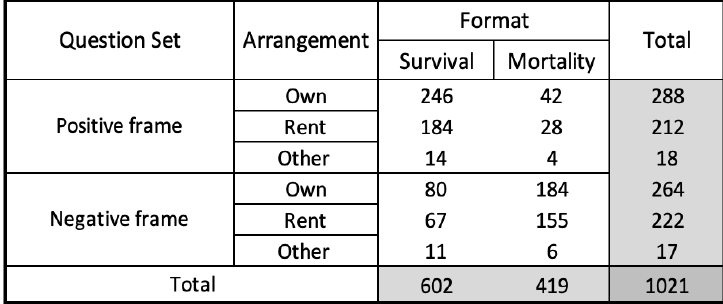
Figure 9. Respondent totals by living status.